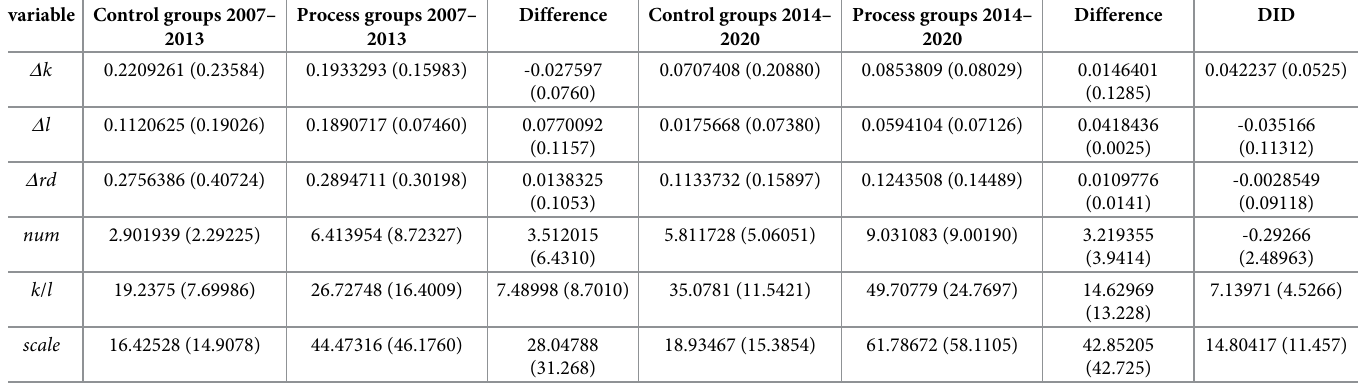
Table 6. Difference in differences estimation results of control